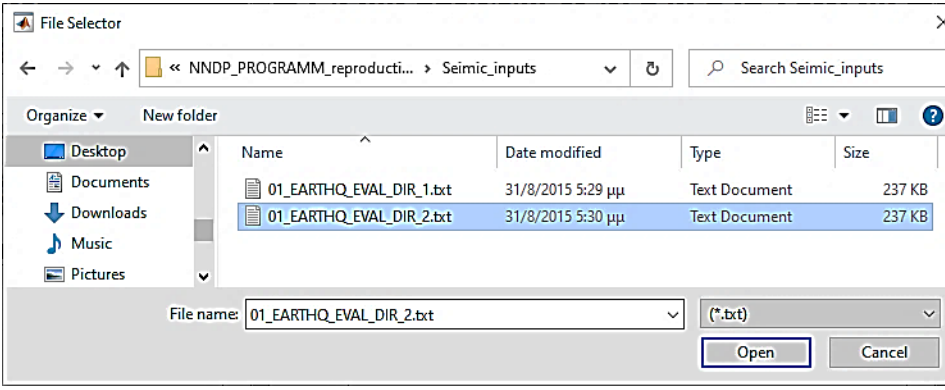
Figure 6. The file selector activated when the two push buttons “FILE” are pushed by the user. The push button entitled “INPUT OF THE STRUCTURAL DATA” activates a window that contains the appropriate GUI control tools/components (i.e., “static text”, “edit text”, and “popup menu”) for the insertion of the required structural data (Figure 7a). It should be outlined that the inserted structural data are used for the formation of the input vector for the trained ANNs and the DS prediction as well as for the seismic damage assessment and prioritization of the RC building studied, in line with the FSRVS rating system proposed by E.P.P.O. [44].